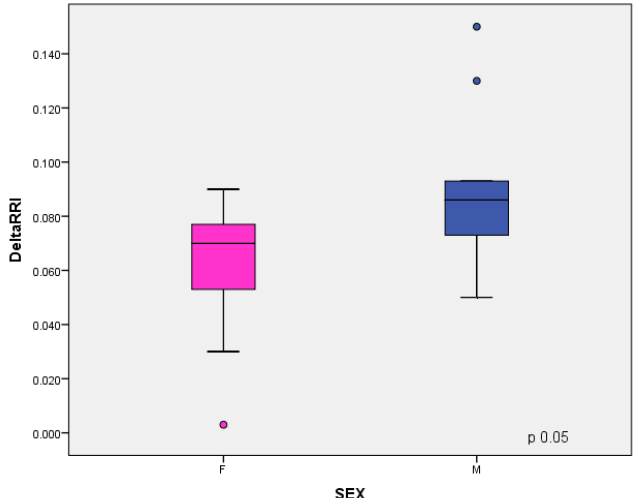
Figure 5. Delta RRI in male and female patients. Box plot showing the differences of Delta RRI between male and female subsamples. Comparison with Student’s t -test for independent samples showed that males had higher Delta RRI values than females.